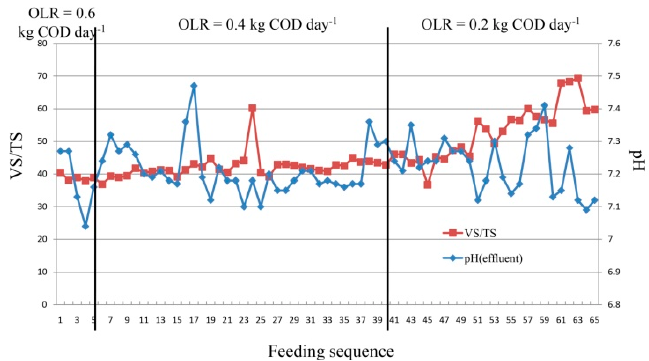
Figure 4. Variations of VS/TS and pH value during the experiments.